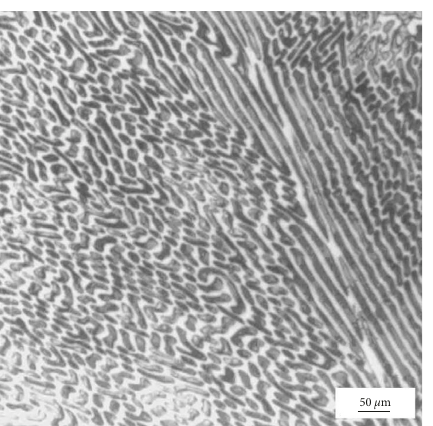
Figure 5: Solidification structure of Fe without undercooling and ECP treatment.